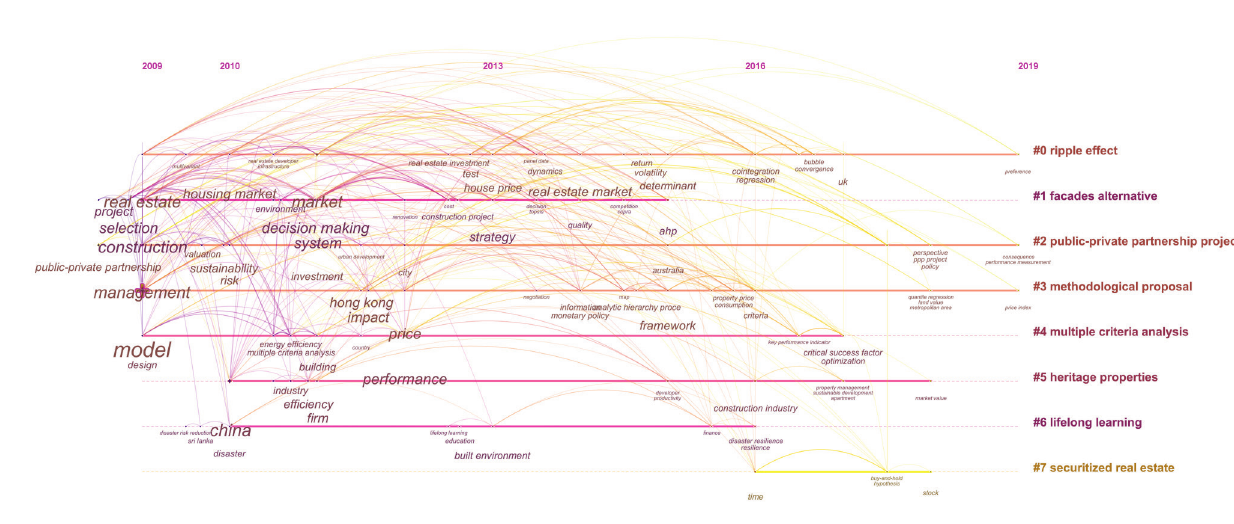
Figure 12. Timeline view for the IJSPM